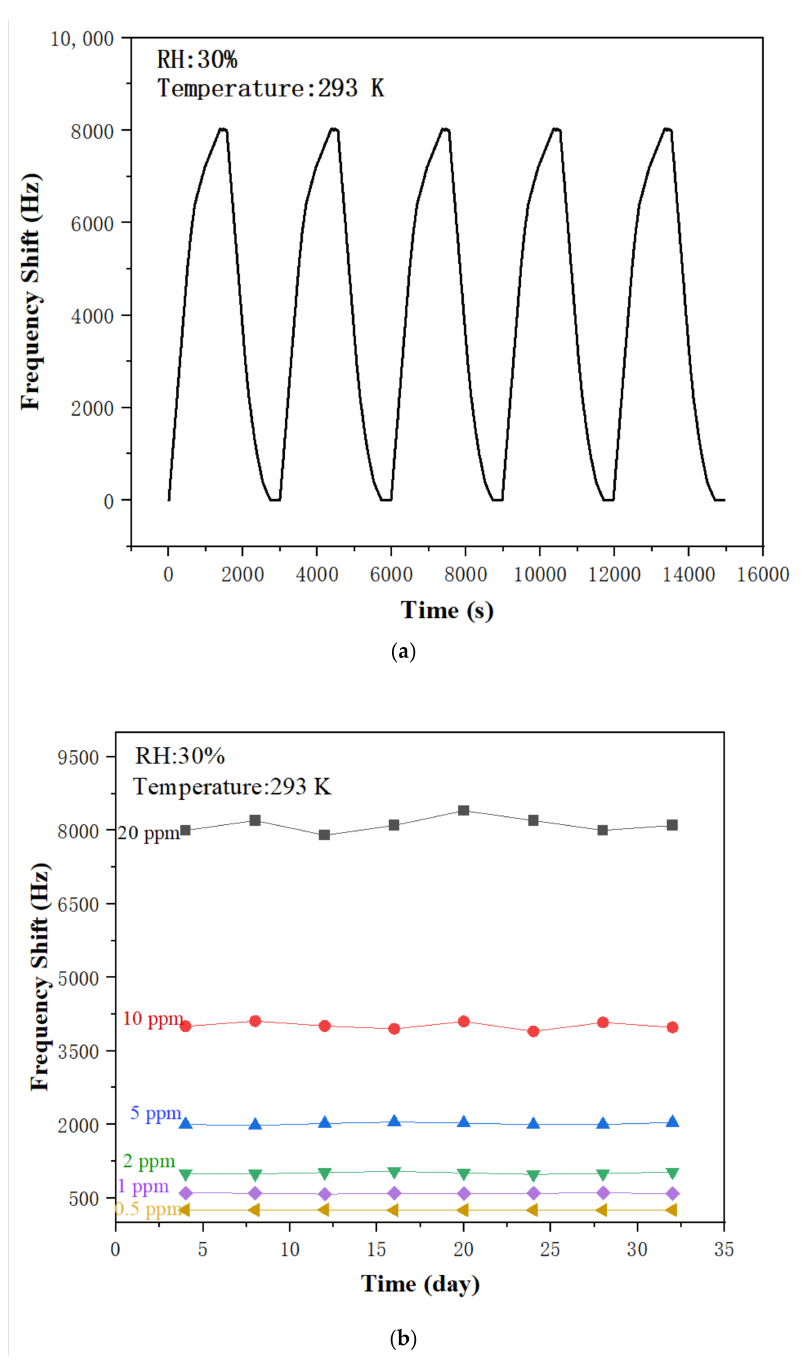
Figure 10. ( a ) Short-term repeatability of the PAA SAW sensor to 20 ppm ammonia; ( b ) long-term stability of the PAA SAW sensor to 20 ppm